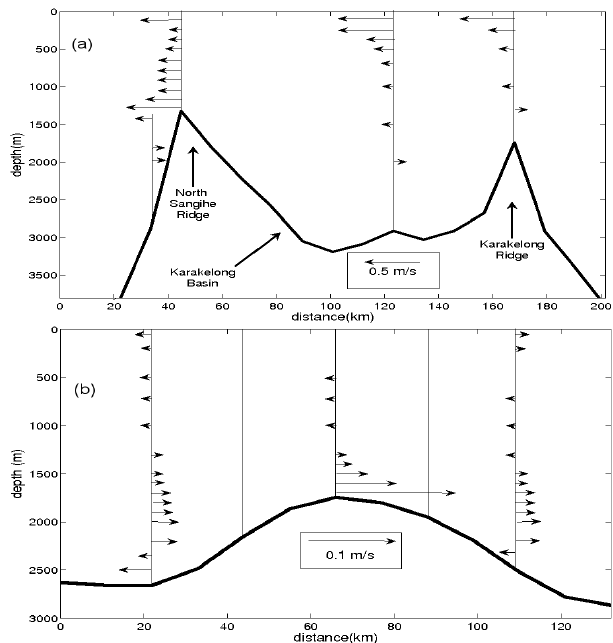
Fig. 6. (a) u velocities in ms − 1 at the section through the sill in the North Sangihe Ridge from east (right) to west (left), see Figs. 1 and 2 for location. (b) v velocities in ms − 1 at the section through the Lifamatola Passage (at i =138) from north (South Maluku Sea, left, j =154) to south (Seram Sea, right, j =146), see Fig. 1 for i,j coordinates and section location (thick black line). The five vertical lines in (b) show the locations of profiles presented and discussed in Sect. 4 of the paper. The distance referred to on the abscissa is essentially the distance across the sill from the Maluku Sea in the north to the Seram Sea in the south. The actual sill is located at the shallowest point in the section( ∼